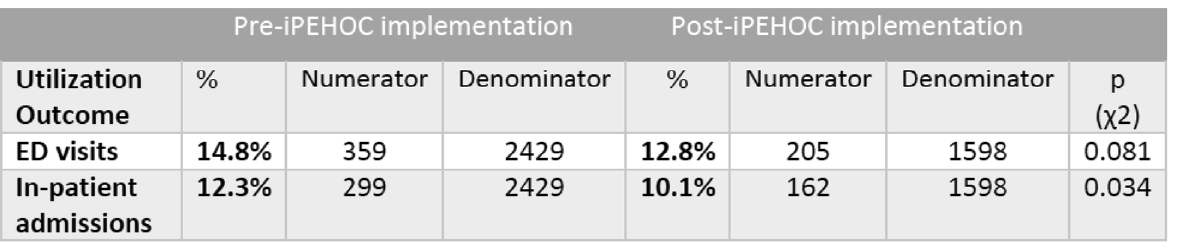
Table 3 Pre/Post Emergency Department Visits and Hospitalization Rates (Ontario